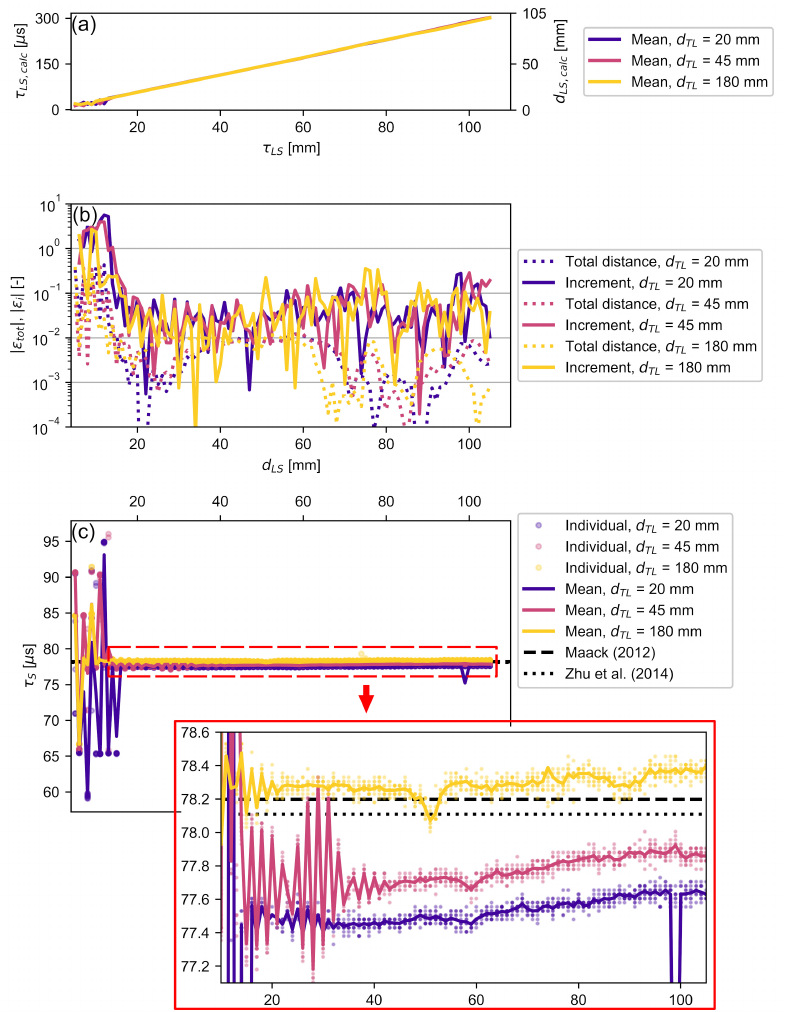
Figure 9. Experimental validation for various d TL and d LS : ( a ) shows the mean calculated distance between laser and specimen as well as the corresponding time delay; ( b ) shows the error for this calculated distance for each individual step as well as for the total distance; ( c ) shows the resulting ToF τ S for each individual pulse and their mean values. Published data [50,60] on longitudinal acoustic velocity in polyamide were used to calculate the reference ToFs. The calculated τ S for d LS are